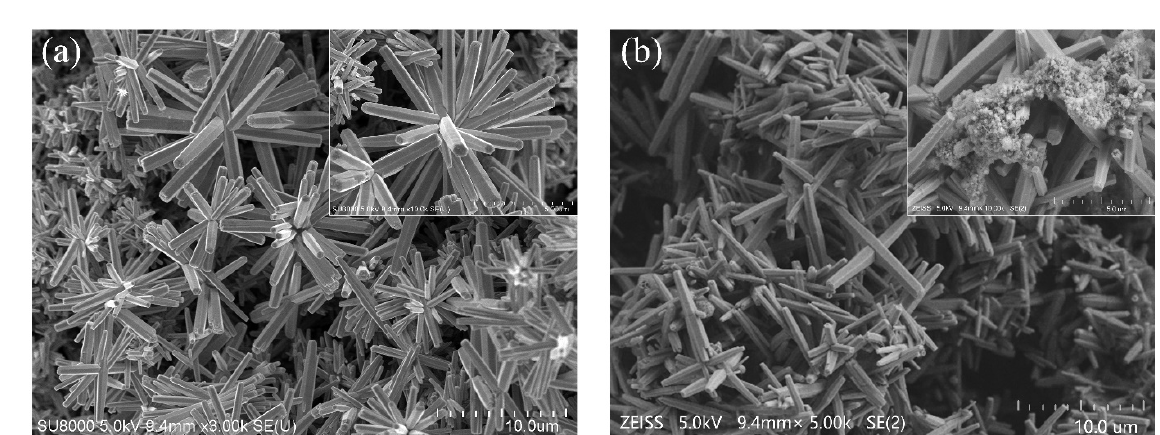
Figure 2. FE-SEM micrographs of ( a ) ZnONFs/Au/PET and ( b ) Fe 3 O 4 MNPs/ZnONFs/Au/PET substrates.